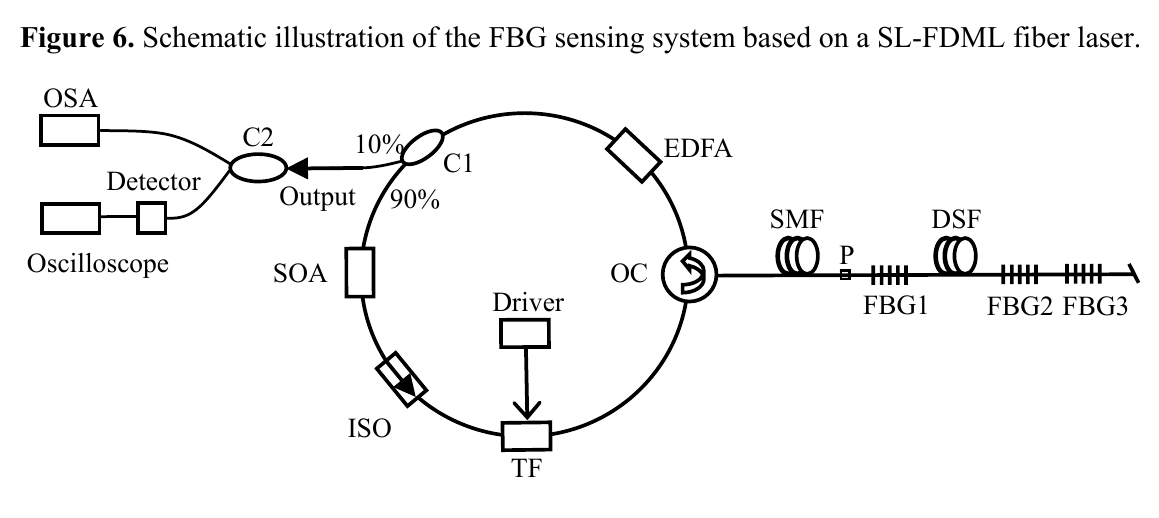
Figure 7. Output spectra of ( a ) the FDML fiber laser, ( b ) the SL-FDML fiber laser driven at 37.432 kHz, and ( c ) the SL-FDML fiber laser driven at 28.776